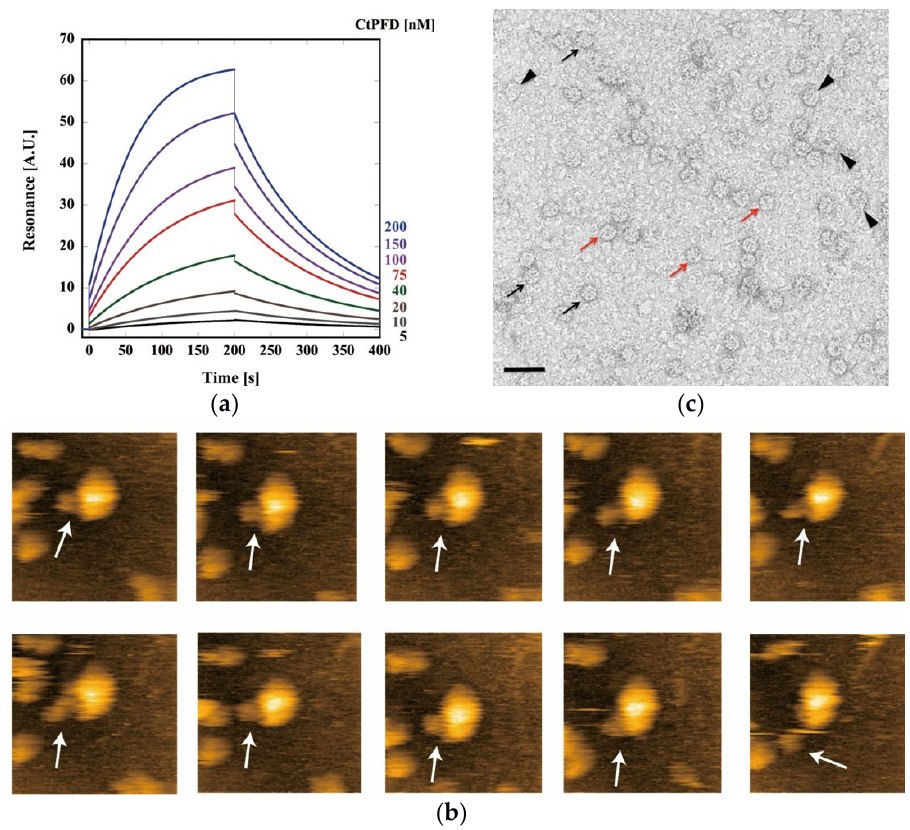
Figure 6. Interaction between CtPFD and CtCCT. ( a ) Sensorgrams of the interactions between CtPFD and CtCCT analyzed with the Biacore T-200 system. ( b ) The time-course of an interaction event between CtPFD and CtCCT observed by HS-AFM. Location of CtPFD is shown with an arrow. ( c ) EM image of CtPFD–CtCCT complexes. Red and black arrows point respectively to end-on and side views of apo-CtCCT, whereas the arrowheads signal the presence of side views of CtPFD-CtCCT complexes. Bar = 500 Å.